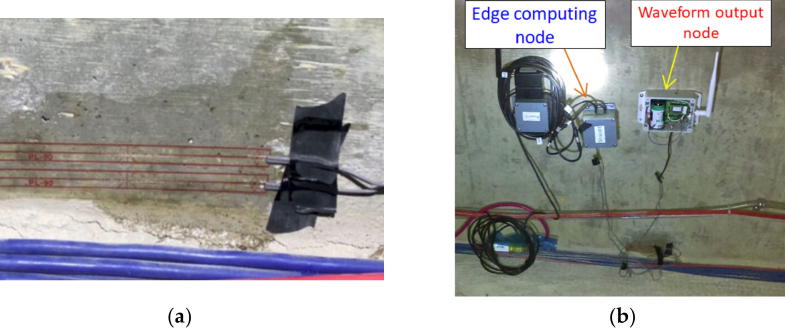
Figure 13. Verification of the functionality of the smart nodes of the wireless dynamic strain gauge: